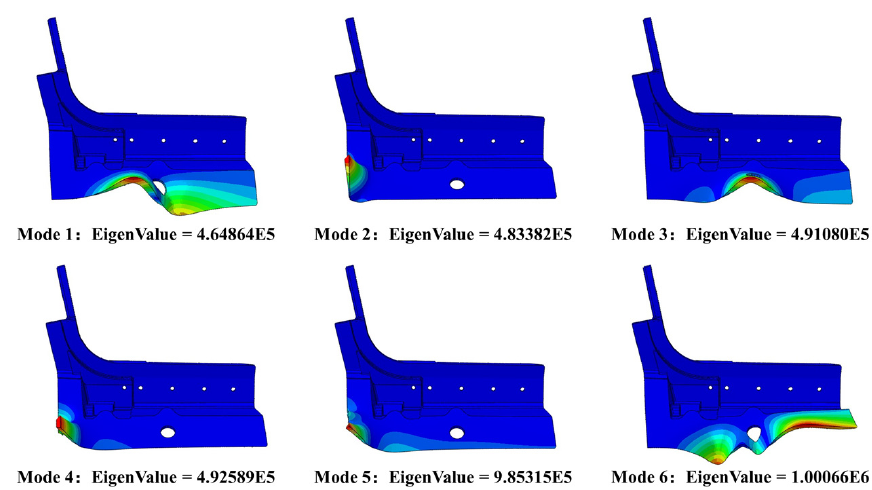
Figure 12. Eigenvalue buckling modes.